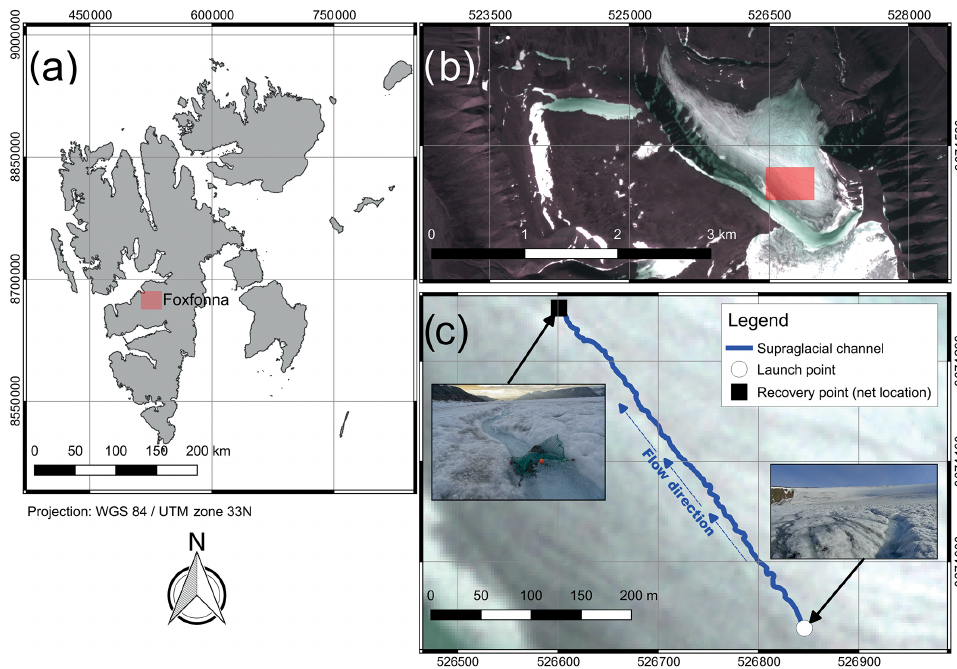
Figure 3. (a) Location of the Foxfonna glacier on the Svalbard archipelago. (b) PlanetScope false-color overview of the Foxfonna glacier and the location of the investigated supraglacial channel acquired on 1 August 2018. (c) Close-up of the studied supraglacial channel. Background image from PlanetScope acquired on 1 August